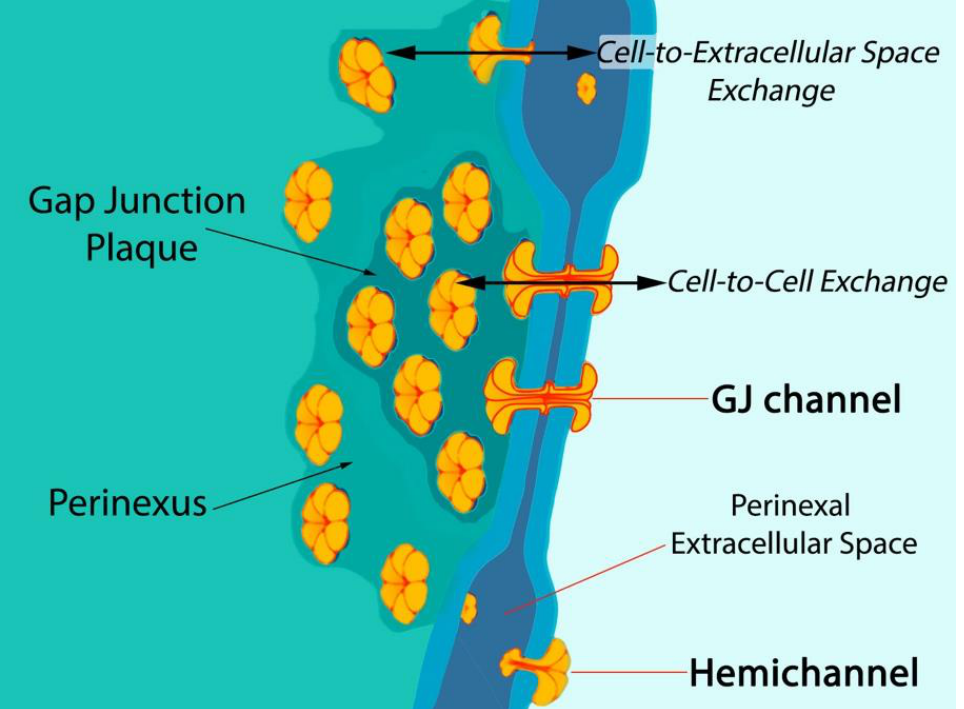
Figure 1. Model of gap junction between two cells. Connexon hemichannels dock to form intercellular channels coupling the cells, enabling cytoplasmic exchange of ions and small molecules typically less than 1000 Da in molecular weight. Undocked hemichannels, concentrated in the perinexus surrounding the gap junction [8], are typically closed but can open in response to prompts like ischemic stress. Open hemichannels thereby underpin flow of channel-permeant molecules from the cytoplasm into the extracellular space.